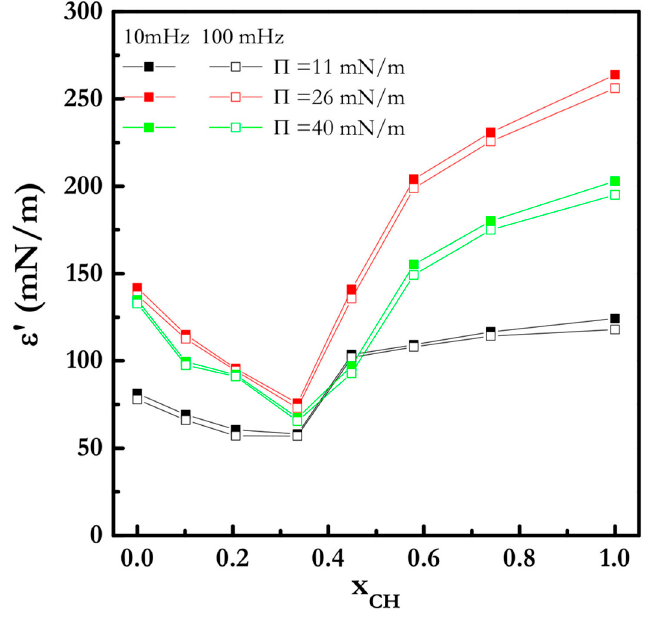
Figure 5. The surface elasticity moduli of the CH/CS mixture vs. xCH at different surface pressures at 35 ◦ C; taken from